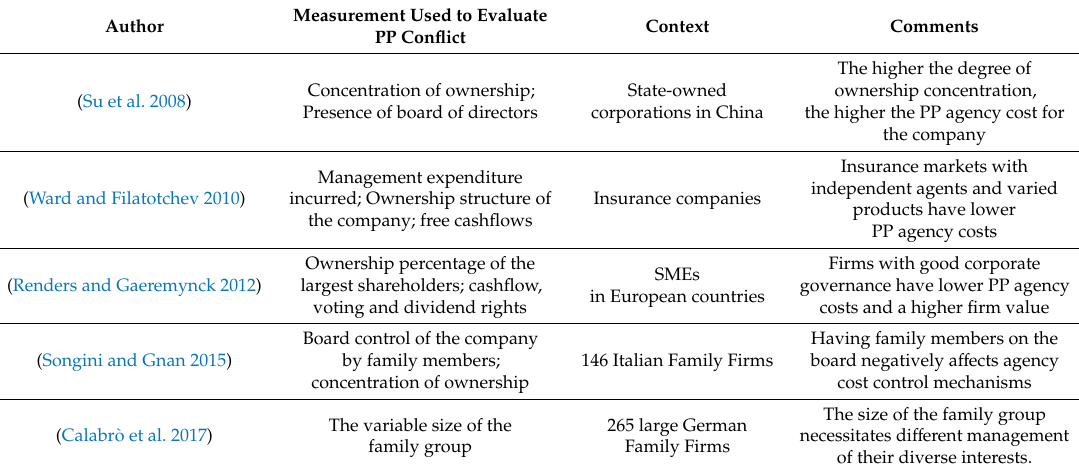
Table 1. Measurement of PP conflict in the literature.